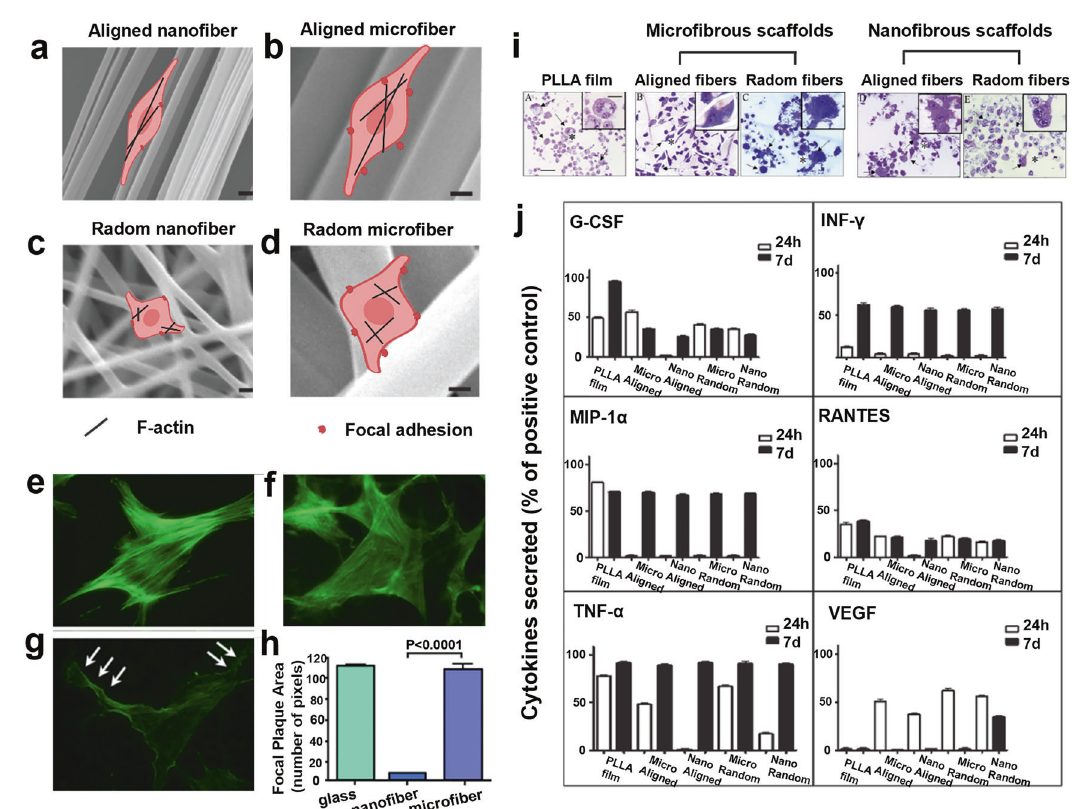
Fig. 6 The effects of hydrogel architecture on cell activities. a – d Schematic image of the interaction between cell and hydrogel scaffolds with different topographies. Cells generally exhibited a spindle-shaped morphology on micro fi bers ( b , d ) or aligned fi bers ( a , b ), while evolved into the rounded morphology on nano fi bers or randomly oriented fi bers ( c ). Reproduced with permission. 249,419 Copyright 2013, Wiley-VCH. The fi gure is made with biorender (https://biorender.com/). e – h Fibroblast F-actin staining (green) on glass ( e ), micro fi ber ( f ), and nano fi ber ( g ), as well as the quanti fi cation analysis of focal plaque area ( h ). The arrows represent membrane protrusions ( “ cork-screw ” ruf fl es). Reproduced with permission. 30 Copyright 2011, Wolters Kluwer Health, Inc. i , j Evidences on how the architecture of hydrogel scaffolds regulated macrophage morphology ( i ) and cytokine expression ( j ), where micro fi bers (1 – 50 μ m) induced M1 microphage activations and more proin fl ammatory cytokine secretions compared to fi bers with a diameter of 200 – 600 nm. Adapted with permission. 257 Copyright 2011, American Chemical